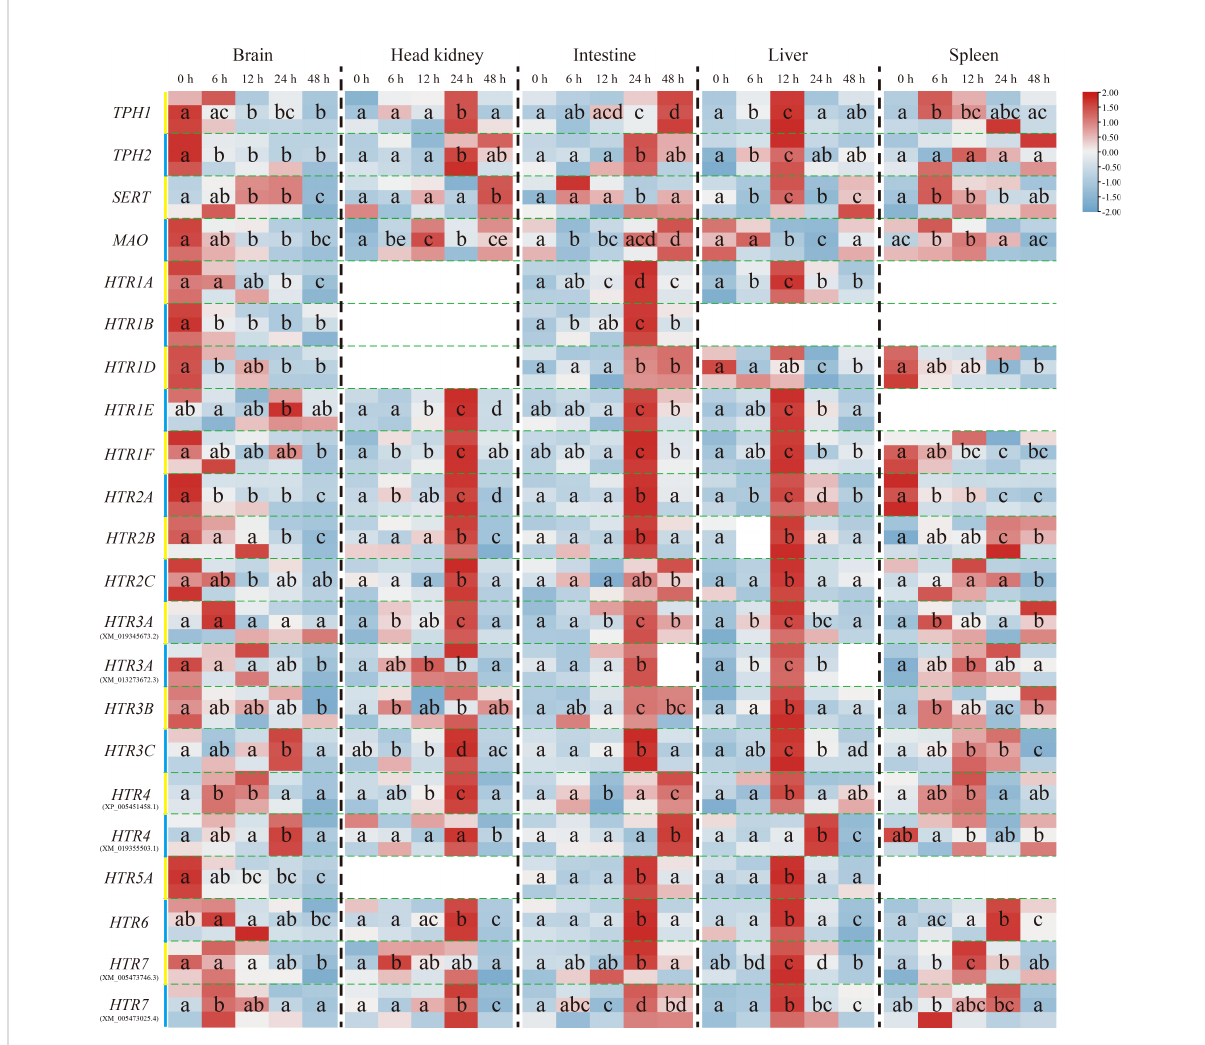
FIGURE 3 Expression patterns of On-TPH1 , On-TPH2 , On-SERT , On-MAO , and On-HTRs mRNA among different tissues (the brain, head kidney, intestine, liver, and spleen) at a series of time points after S. agalactiae injection, as detected via qRT-PCR. The expression level of these genes at 0 h is set as 1.00 to calculate the relative expression of the other time points. n = 3. The signi fi cant difference analysis was using post hoc tests (Tukey HSD test) with one-way ANOVA and the different letters indicated signi fi cant difference ( p <